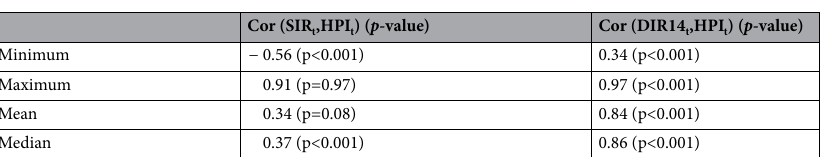
Table 2. Minimum, maximum, mean and median Pearson contemporary correlation coefficient between SIR and HPI, and DIR14 and HPI of 278 mainland Portuguese